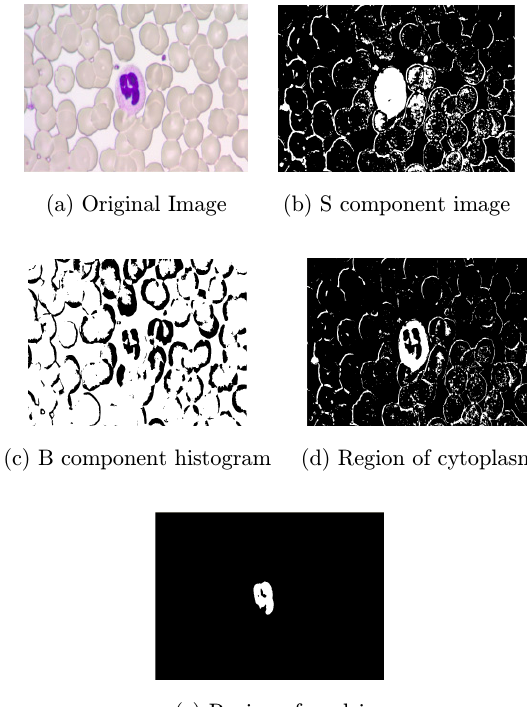
Fig. 2. Binary image of cell nuclei B component and S